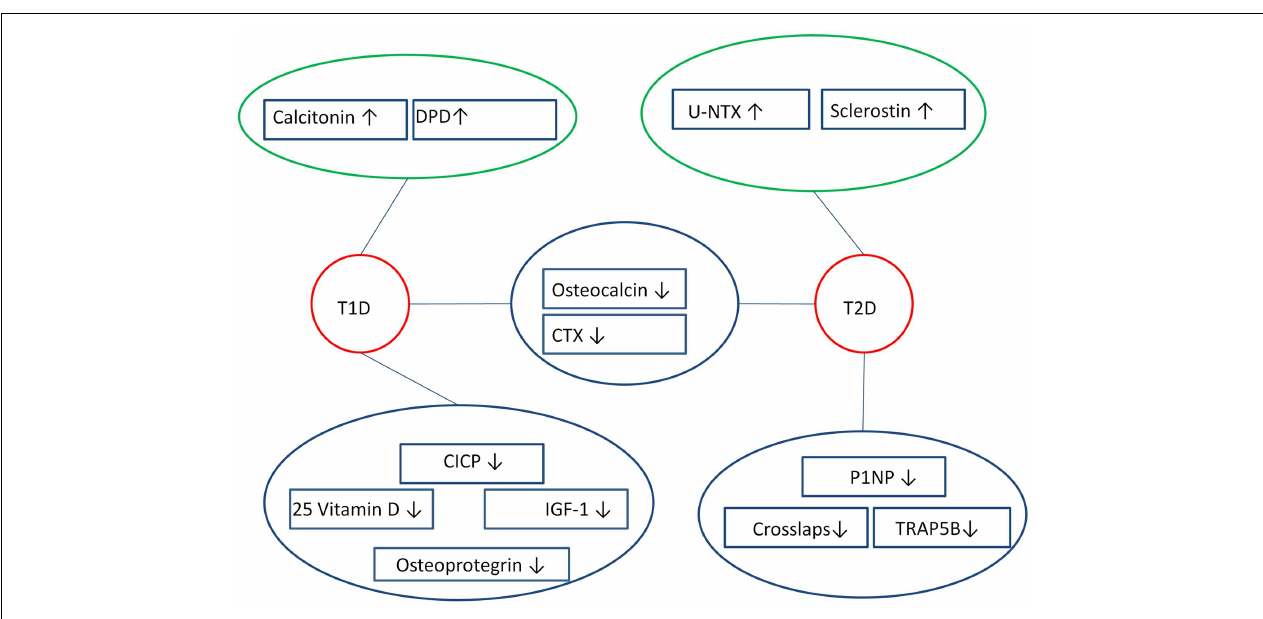
a dissociation in the bone markers among diabetics, as bone markers that do not differ are left out of the figure. ↑ Indicates raised marker, ↓ indicates lowered marker, blue circle surrounds markers that appear to be lowered, green circle surrounds markers that seem to be raised, red circle surrounds